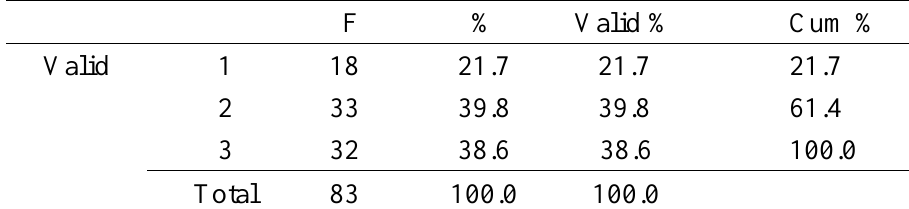
Tabel 7 . P3. Pemahaman Informasi Konten